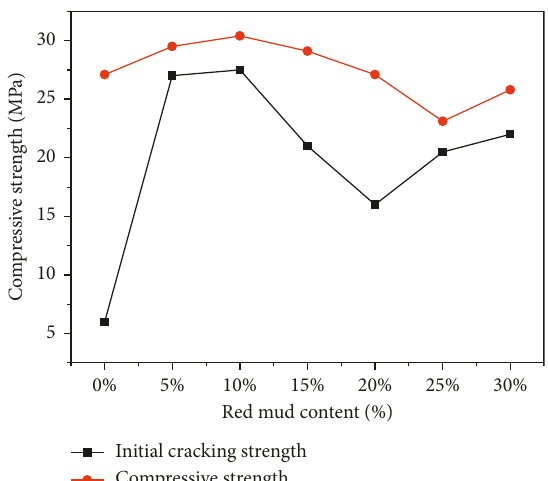
Figure 9: Compressive strength and initial cracking strength as a function of RMC added to concrete cured for 28